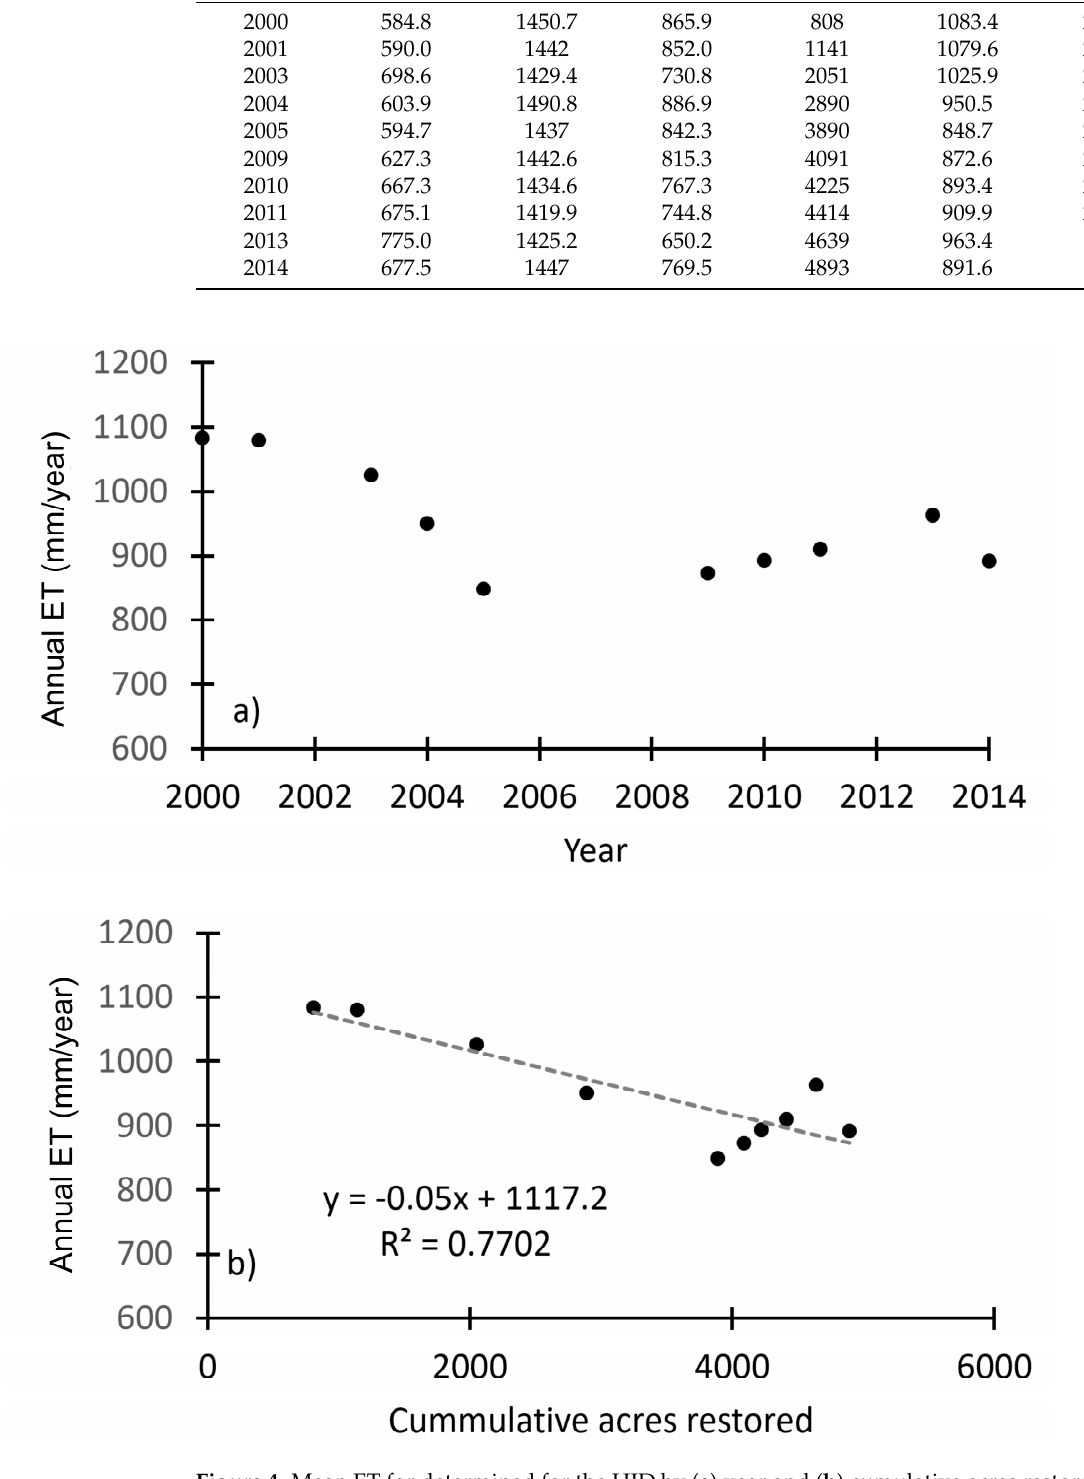
Figure 4. Mean ET for determined for the HID by ( a ) year and ( b ) cumulative acres restored [42]. Table 1. Summary statistics of ET for each year of restoration [42]. Values reported in mm year − 1 .